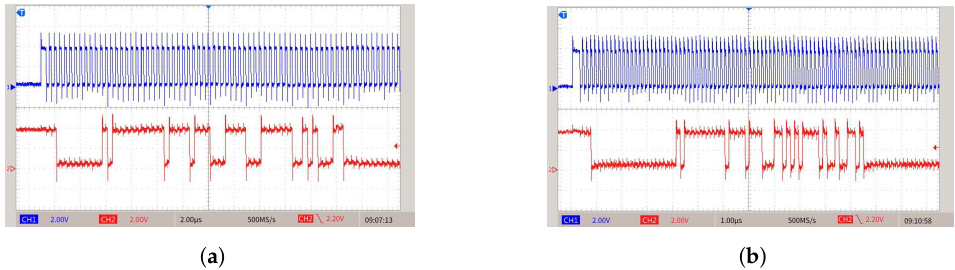
Figure 20. Measured MA (blue) and SLO data signal (red). ( a ) For 2.5 MHz MA frequency. ( b ) For 6.25 MHz MA